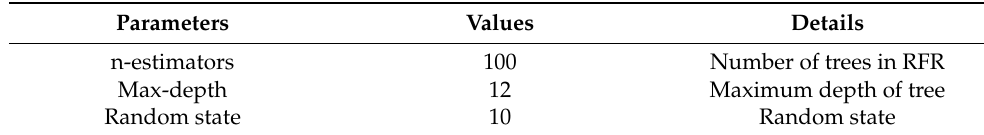
Table 3. Optimized RFR hyperparameters.